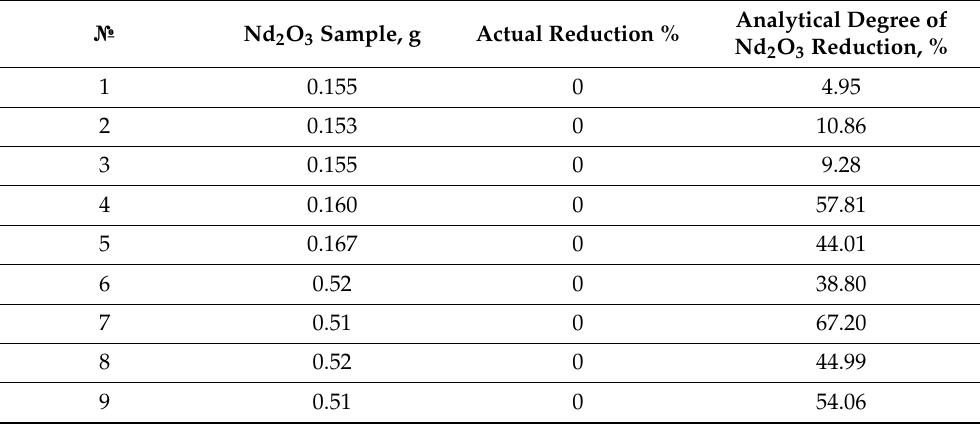
Table 6. Concentration of oxide and metallic phases in model Nd 2 O 3 samples determined by the bromide